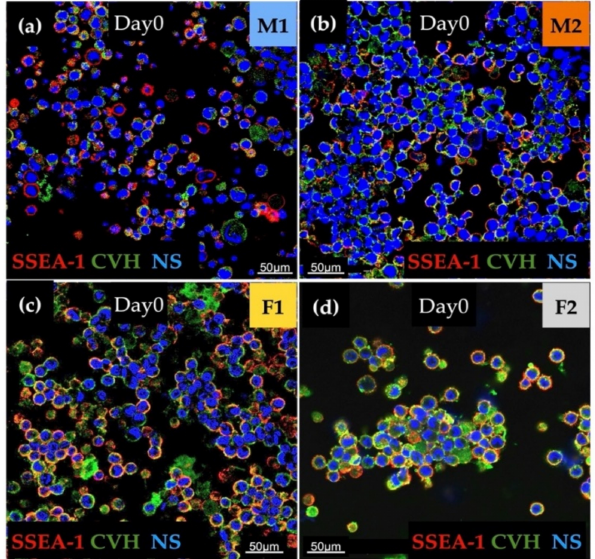
Figure 2. The immunostaining was performed with SSEA-1 (red), CVH (green) and TO-PRO™-3 for nuclear staining (blue). We examined M1 ( a ), M2 ( b ), F1 ( c ) and F2 ( d ) PG cell lines (Scale: 50 µ